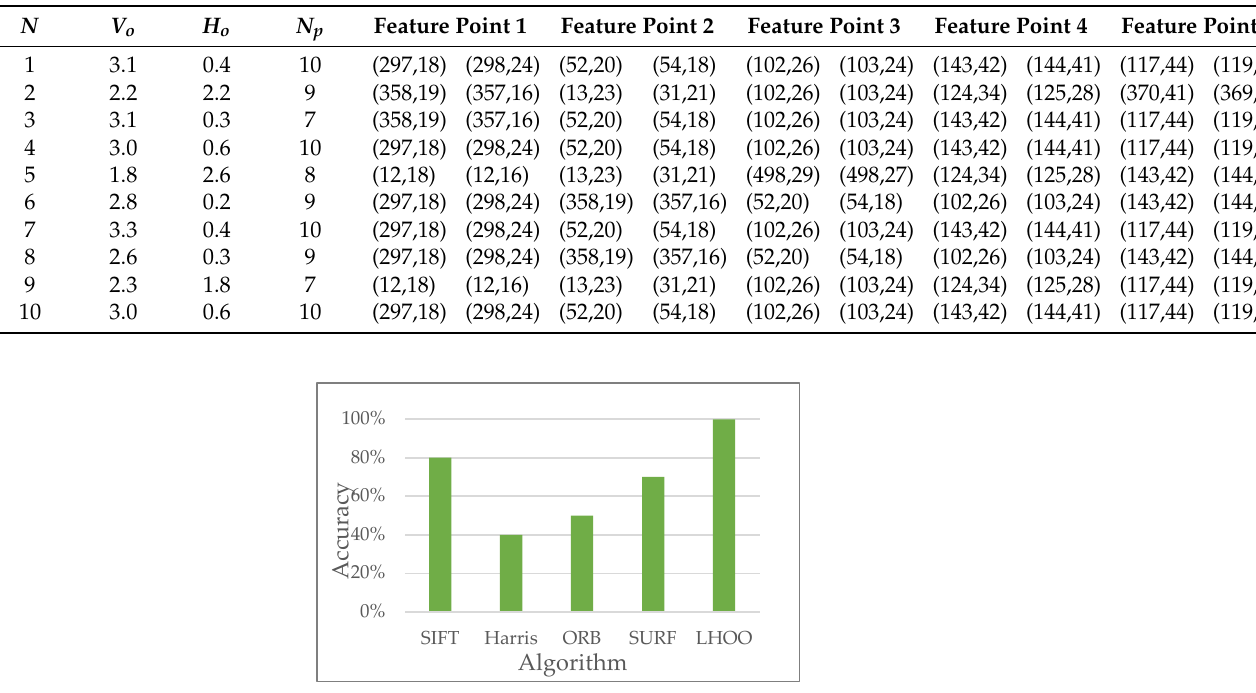
Figure 6. Matching effect of two images. ( a ) Nature image matching result; ( b ) nature image stitch- ing result. ( c – f ) contain the borehole image matching results of SIFT, Harris, ORB and SURF algo- rithms, respectively.